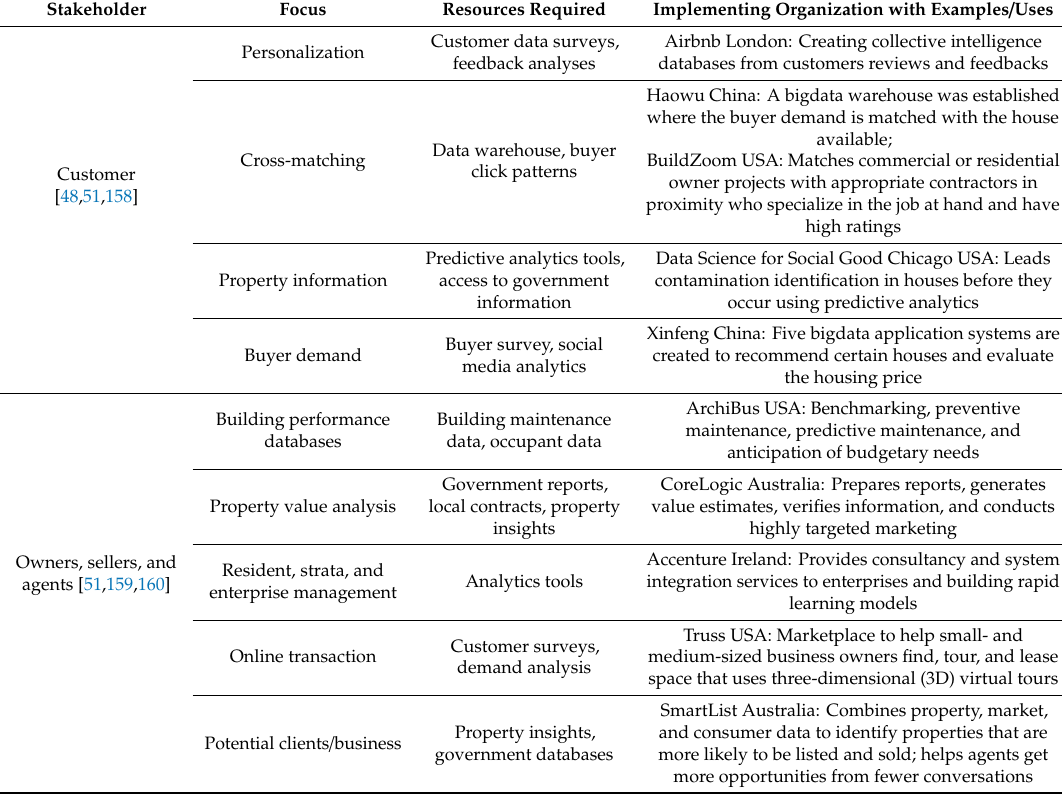
Table 15. Organizations using big data in smart real estate, focusing on stakeholders and required